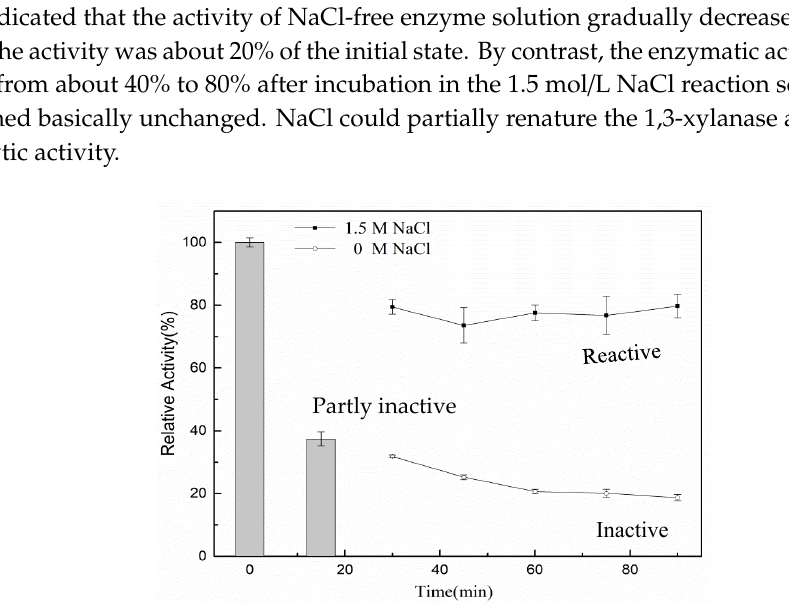
Figure 7. The influences of NaCl on the thermostability of the rXyl88. The activity of rXy188 was detected at 45 °C. Bars show the relative activity of rXyl88 in the initial time and the 15th min after incubation, respectively. The lines with disc symbol and hollow circle were carried out without supplementary of NaCl and in the presence of 1.5 mol/L NaCl, respectively. All assays were performed in triplicate, and standard deviations are shown with error bars.